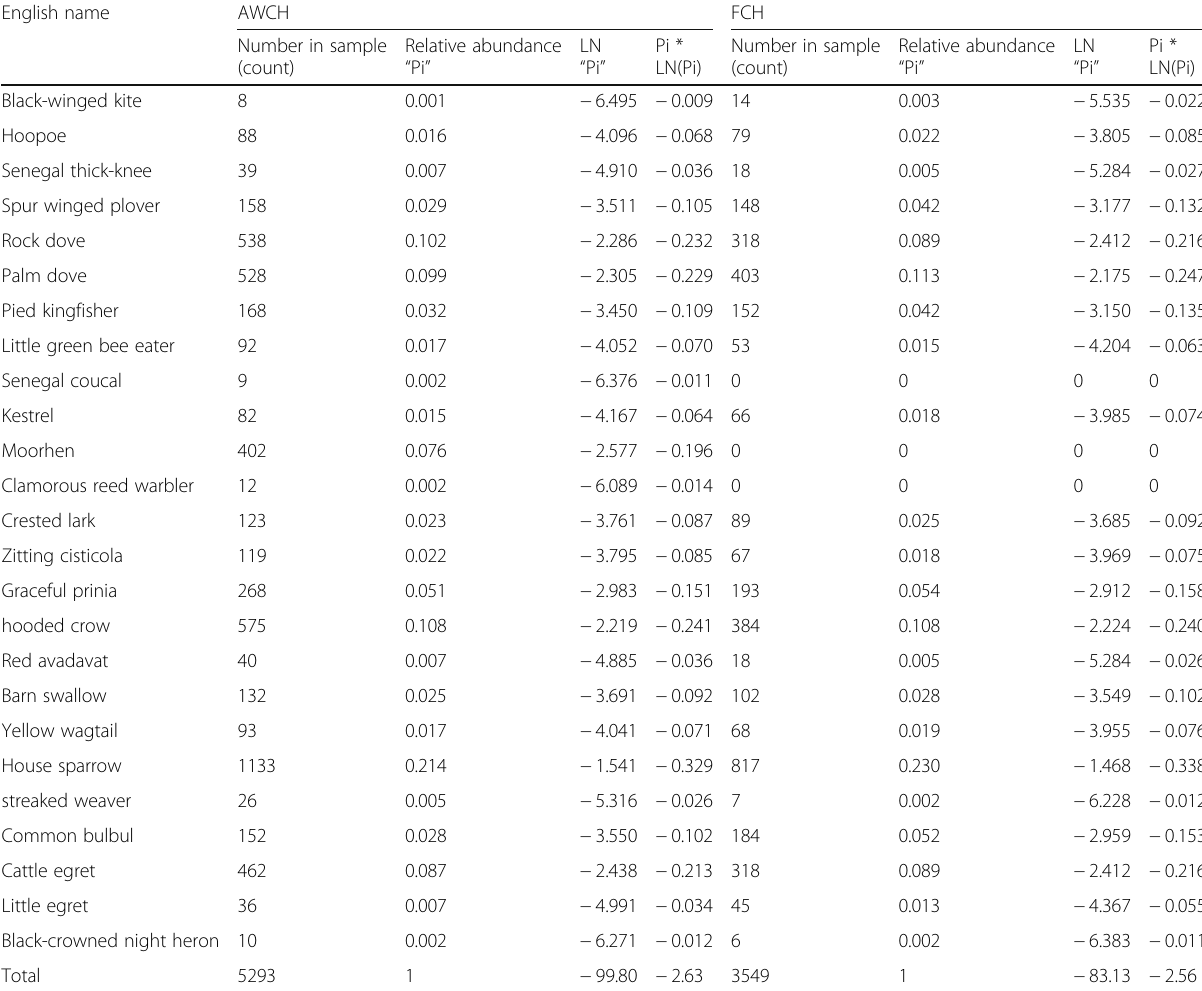
Table 2 Relative abundance of resident wild birds observed at Sharkia